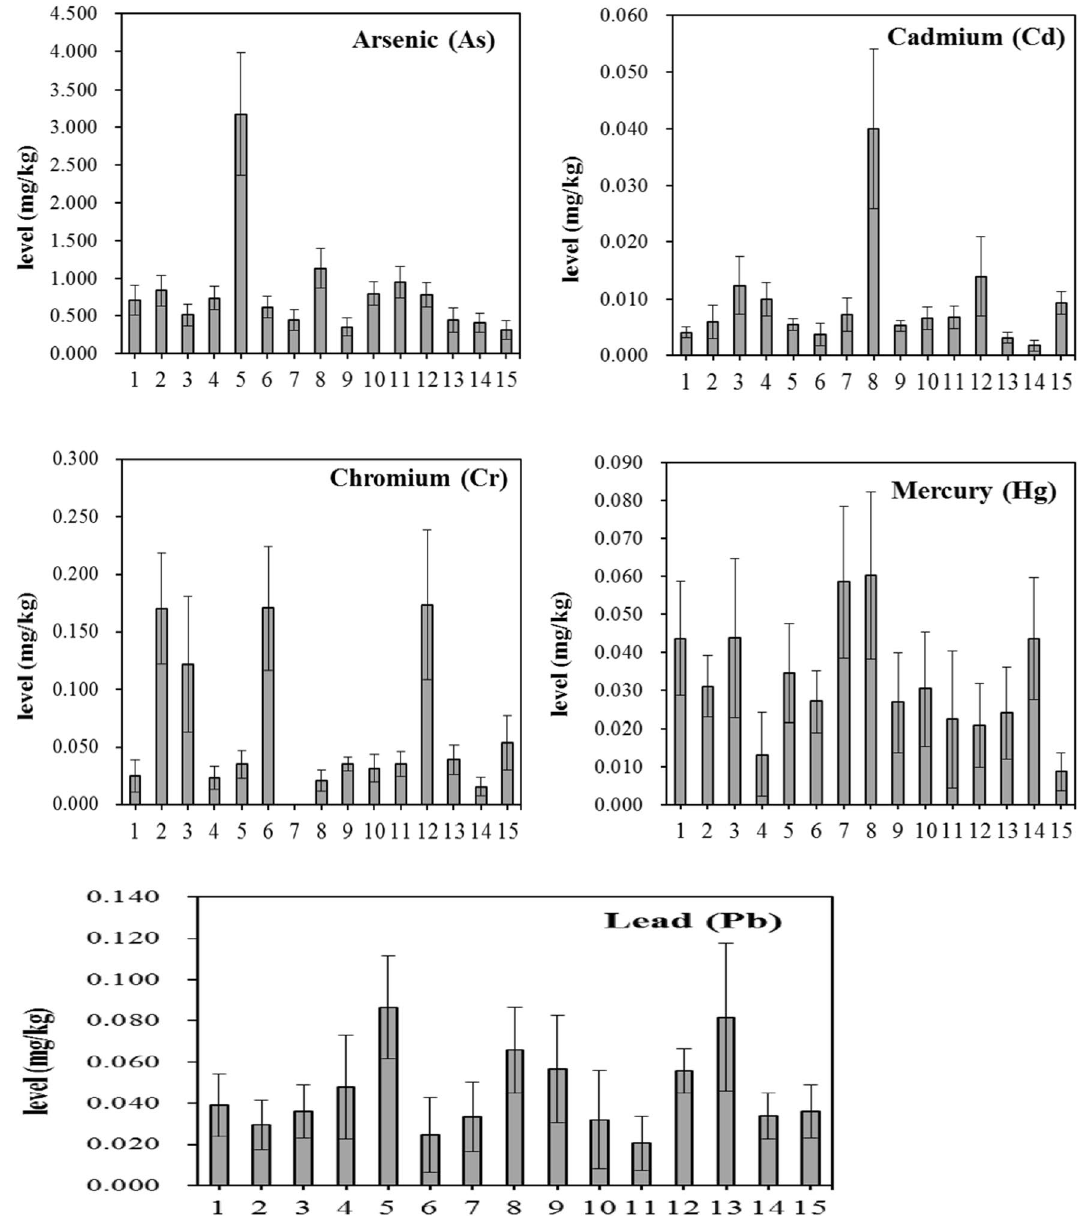
Figure 2. The distribution of the As, Cd, Cr, Hg and Pb in marine fish from Zhejiang province, China (mean ± standard error). 1, Large yellow croaker ( Larimichthys crocea ); 2, Little Yellow Croaker ( Larimichthys polyactis ); 3, Largehead hairtail ( Trichiurus lepturus ); 4, Light maigre ( Collichthys lucidus ); 5, Flounder ( Pleuronectiformes ); 6, Sea bass ( Lateolabrax japonicus ); 7, Leuciscus waleckii ; 8, Pacific saury ( Cololabis saira ); 9, Miichthys miiuy ; 10, Pneumatophorus japonicus ; 11, Scomberomorus niphonius ; 12, Pomfret ( Pampus argenteus ); 13, Flathead grey mullet ( Mugil cephalus ); 14, Bennett ( Ilisha elongata ); 15, Harpadon East China Sea. Previous reports also found 0.56–23.3 mg/kg in fish from Croatia 28 , 0.4–1.3 mg/kg in fish from Bangladesh (Dhaka) 29 , 1.23–44.54 in fish from South Korea 30 . Our results showed that the highest average level of As (3.172 mg/kg) was found in flounder ( Pleuronectiformes ). Arsenic can be presented in several organic (trivalent and pentavalent arsenic) and inorganic (elemental, trivalent and pentavalent arsenic) forms. Organic As showed low toxicity does not accumulate due to the rapid excretion in the human body 31 . Up to 90% of As in fish muscle is present in the non-toxic arsenobetain form 32,33 . However, according to MAC (0.1 mg/kg) for inorganic As (iAs) in China, there could be some samples exceed- ing the MAC in this study. Cadmium (Cd). The concentration of Cd was found at the mean of 0.009 mg/kg (average range of 0.002– 0.040 mg/kg). One sample (pomfret, Pampus argenteus ) of 652 contained higher level than the MAC of 0.1 mg/